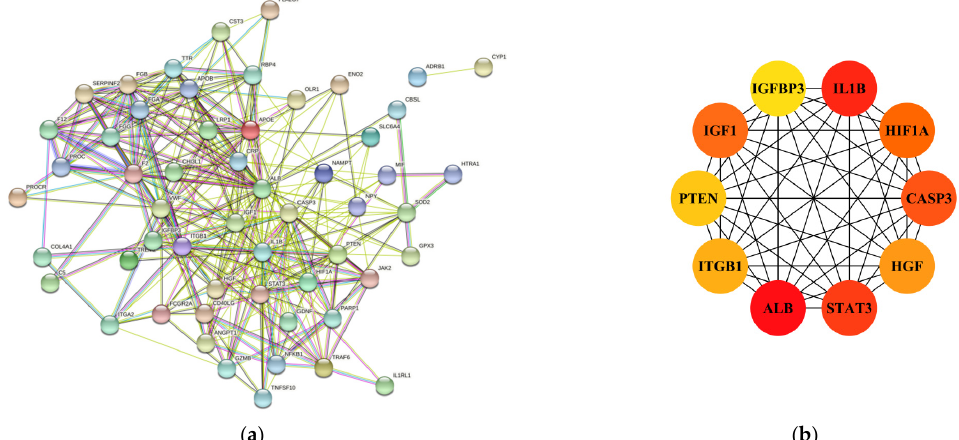
Figure 2. PPI network analysis of the IS-DEGs identified. ( a ) PPI network of all the IS-DEGs (interaction score >0.4). ( b ) The interaction network of top 10 hub genes.